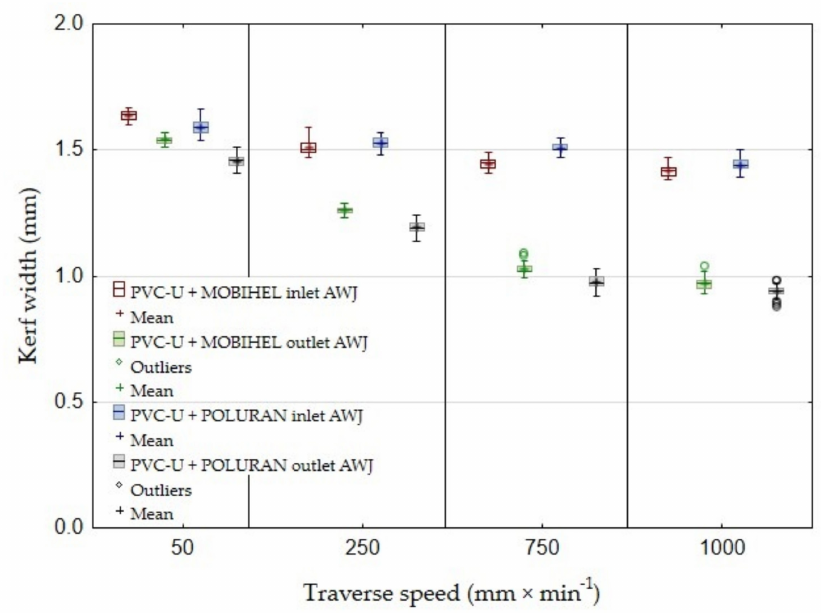
Figure 10. Comparison of the width of cutting gaps created by AWJ technology on the inlet and outlet side of the waterjet in PVC-U material with different surface